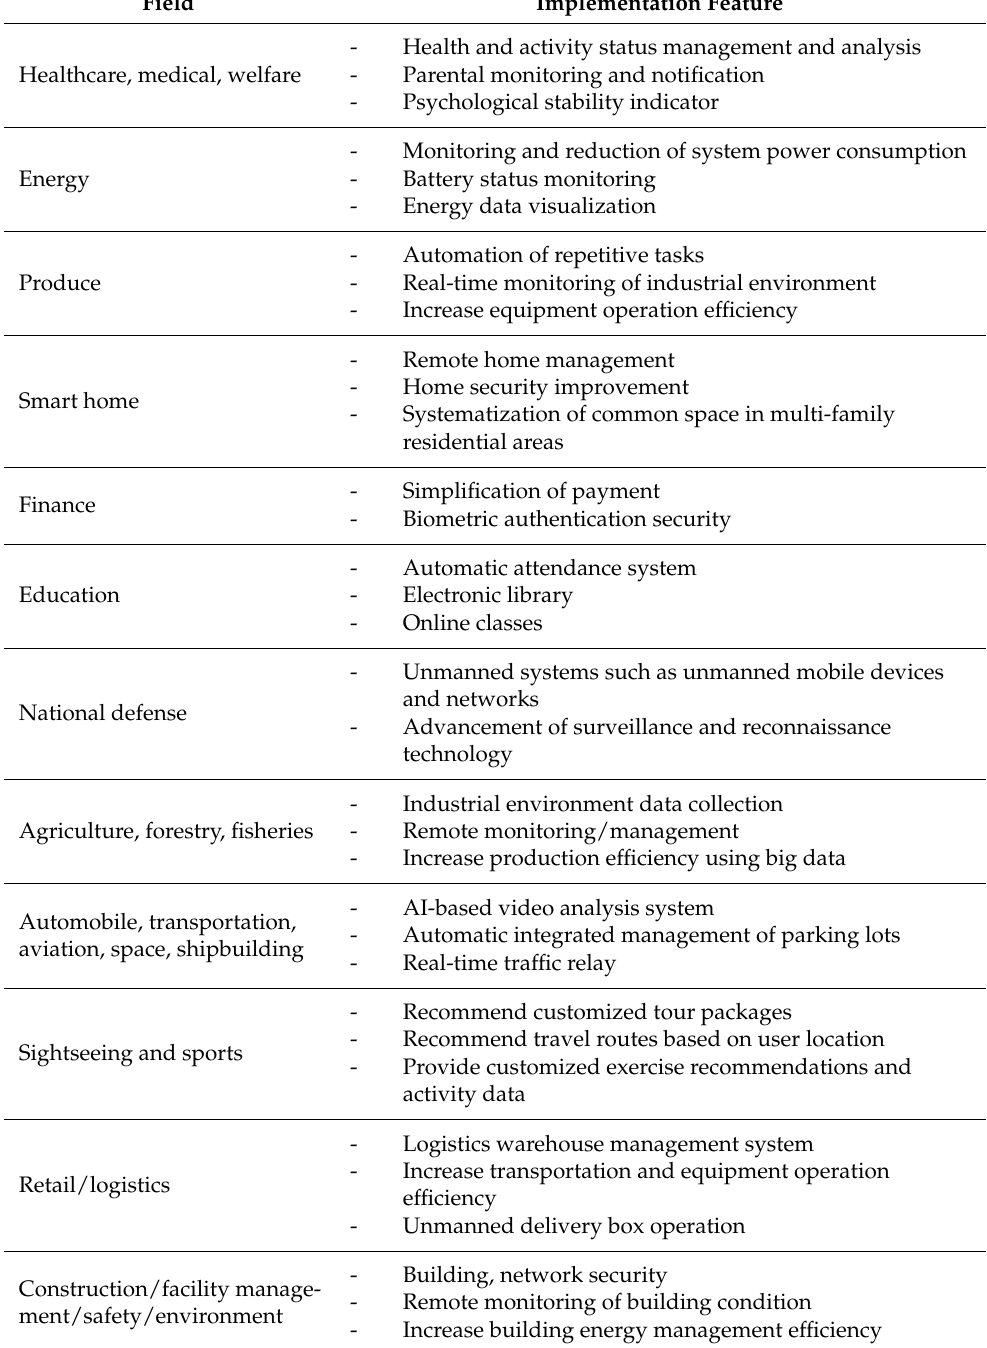
Table 3. IoXT Service